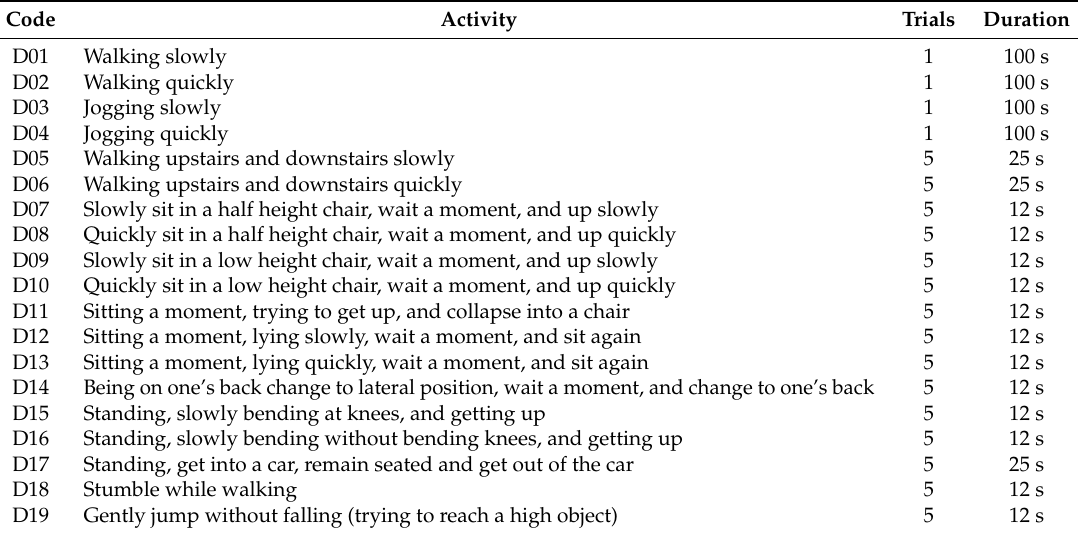
Table 2. Types of activities of daily living selected for this